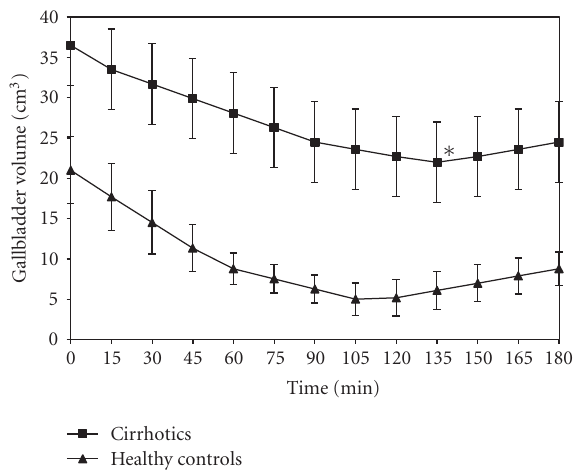
Figure 1: Gallbladder emptying curves after the test meal in Child- Pugh class A cirrhotic patients and in healthy controls (mean ± SD). The asterisk indicates statistical significant di ff erence in cirrhotics ( P < . 0001) versus